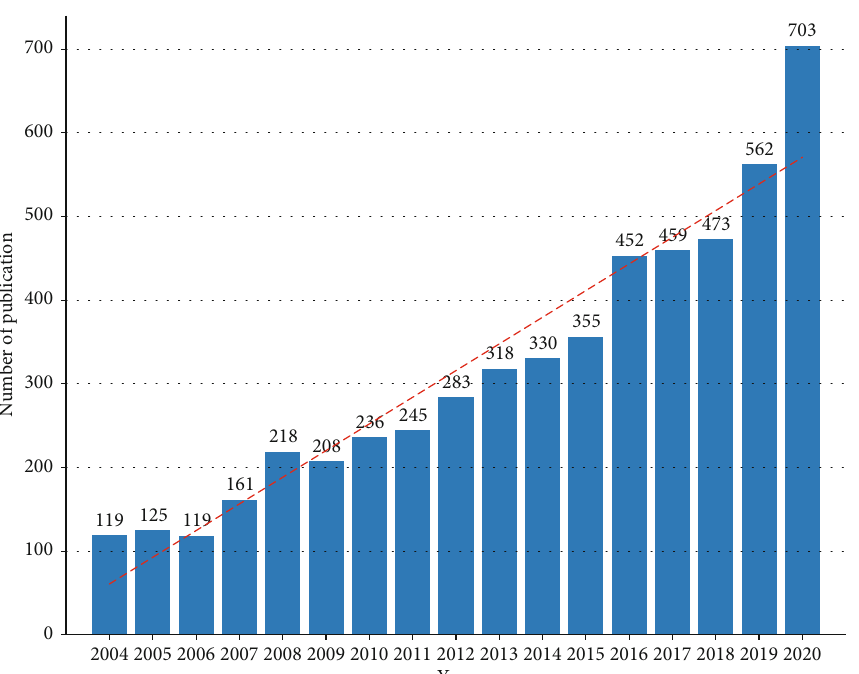
Figure 2: Annual number of publications on DFUs from 2004 to 2020.